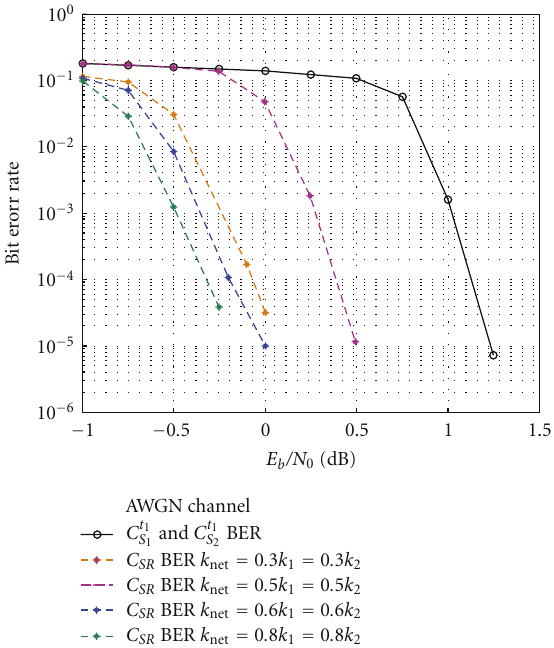
Figure 16: The BER performance under the AWGN channel with di ff erent lengths of extra check bits.